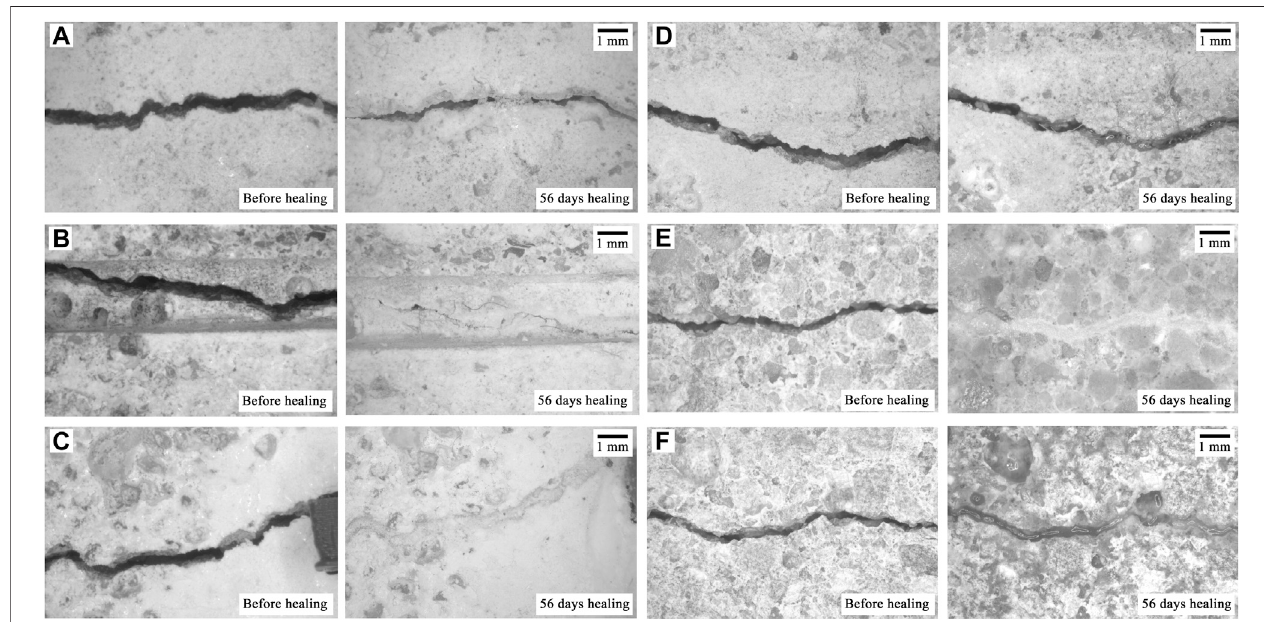
FIGURE 6 | Optical microscope images of cracked specimens before and after 56 of healing incubation. One specimen for each series tested through water permeability test is reported (a for Ctrl-28d, b for PLA-28d, c for AKD-28d, d for Ctrl-6m, e for PLA-6m, f for AKD-6m).